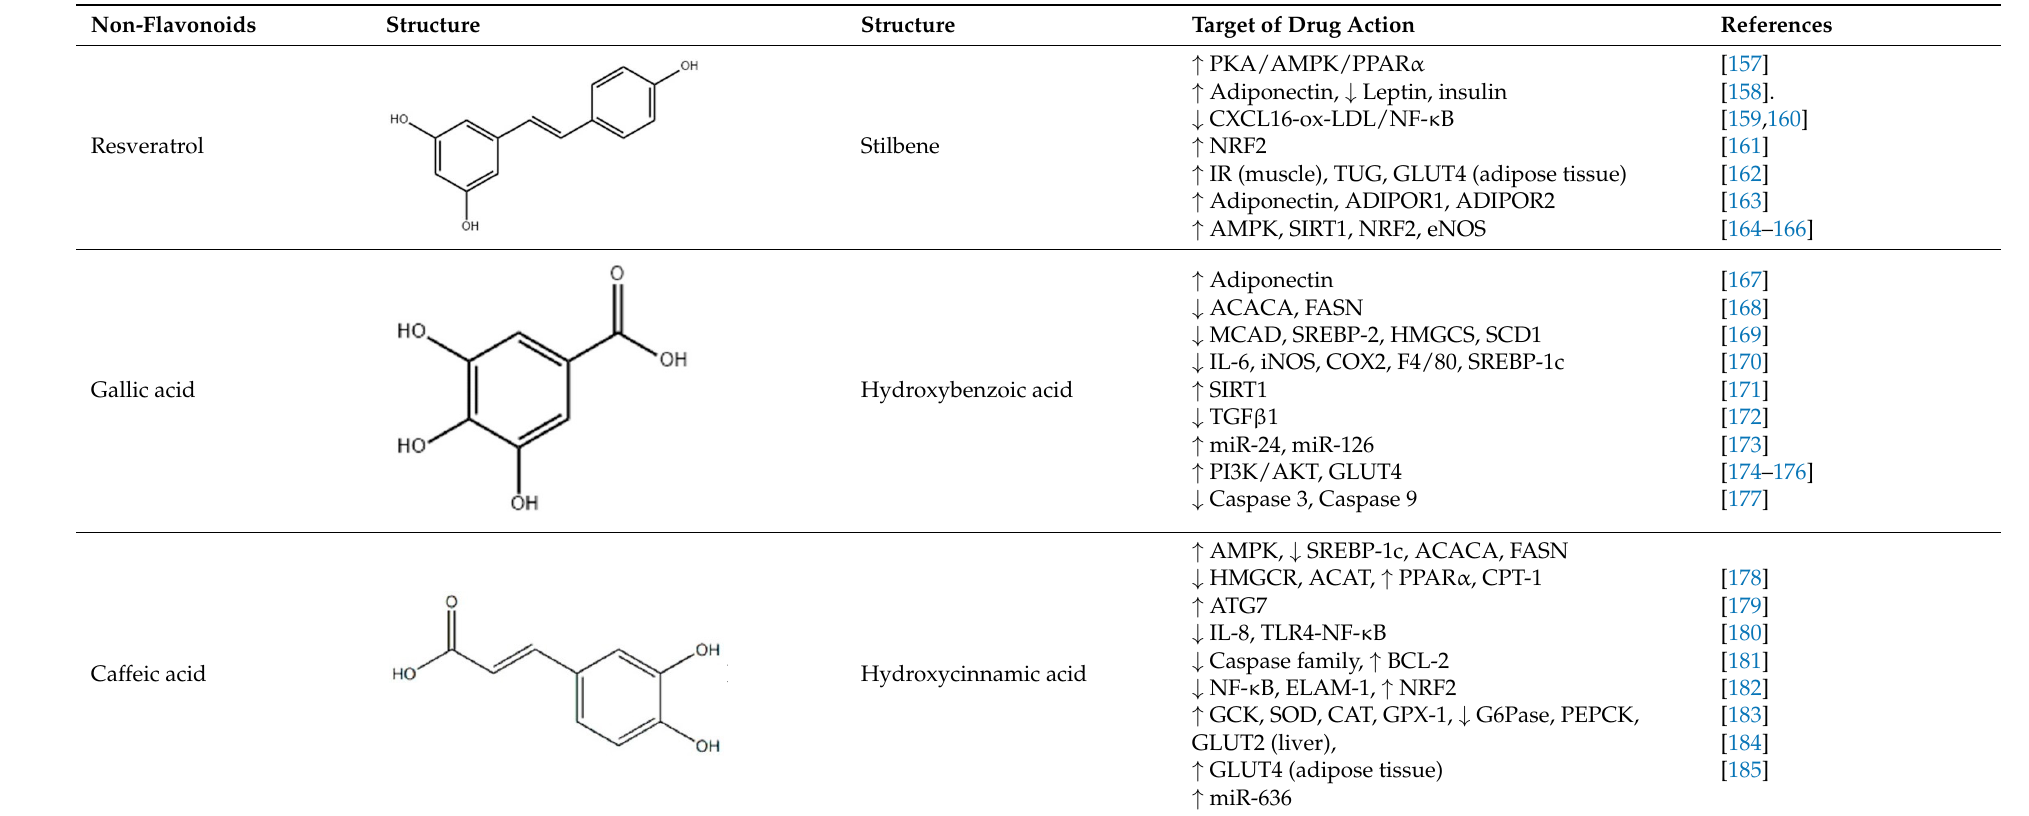
Table 3. Structure and classification of non-flavonoids and their mechanisms of action targeting MetS.